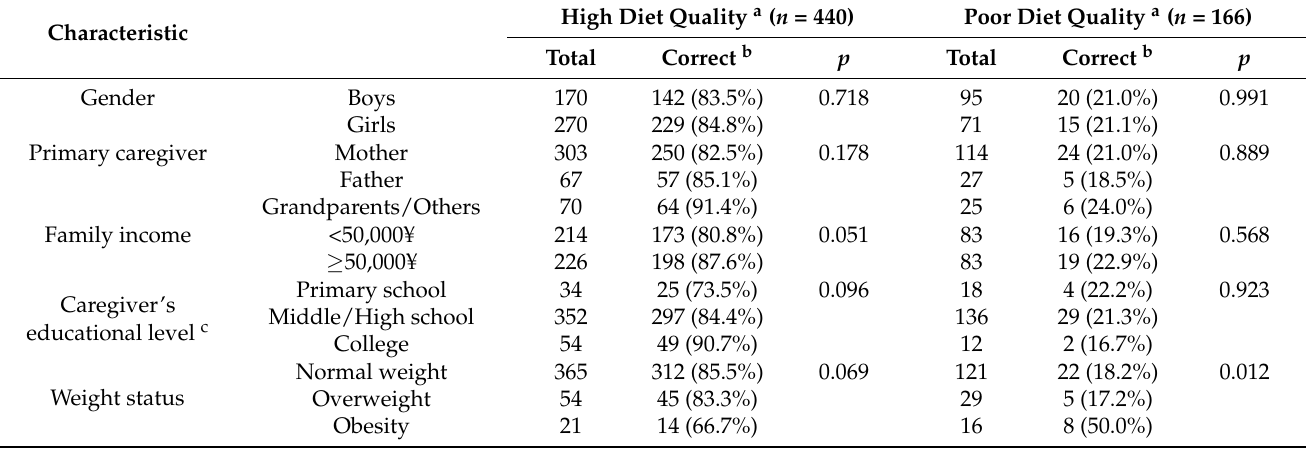
Table 3. The correctness of caregiver’s perception of diet status of children in with differing diet